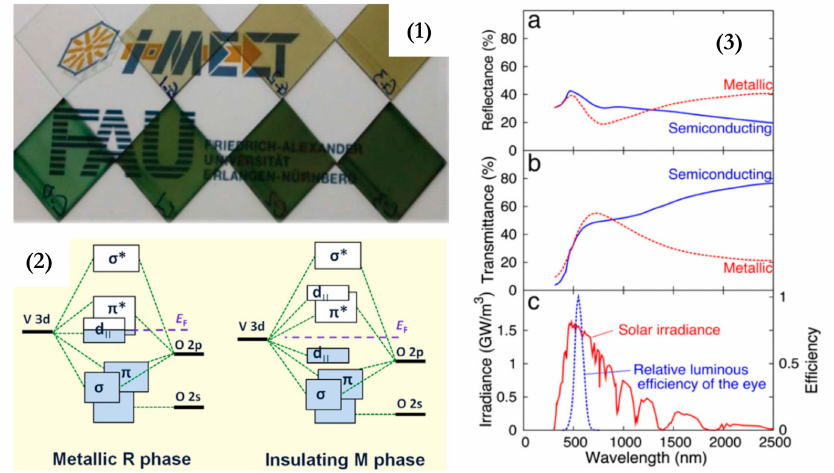
Figure 2. ( 1 ) Pictures of VO 2 -based thermochromic (TC) samples, ( 2 ) Band structures of the metallic rutile and insulating monoclinic phases of vanadium dioxide (VO 2 ). Reproduced from [43], Elsevier: 2018. ( 3 ) Spectral reflectance ( a ) and transmittance ( b ) for a 50 nm VO 2 film. Panel ( c ) illustrates spectra for the luminous e ffi ciency of the human eye and solar irradiance. Reproduced from [42], Elsevier: